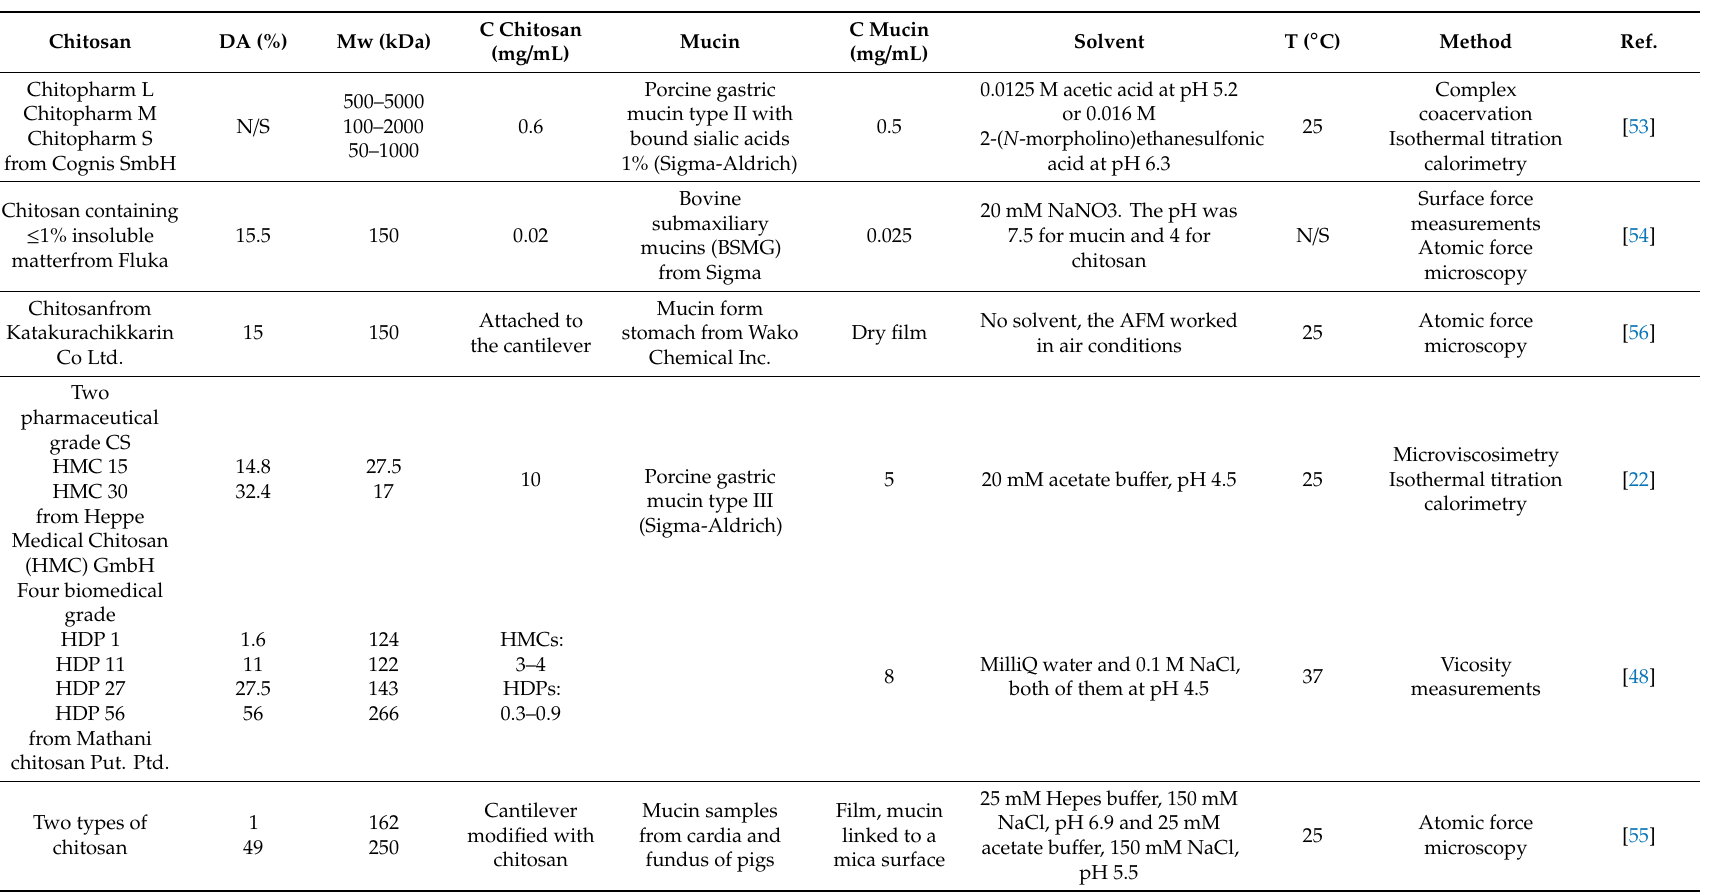
Table 1. Interaction between chitosan and